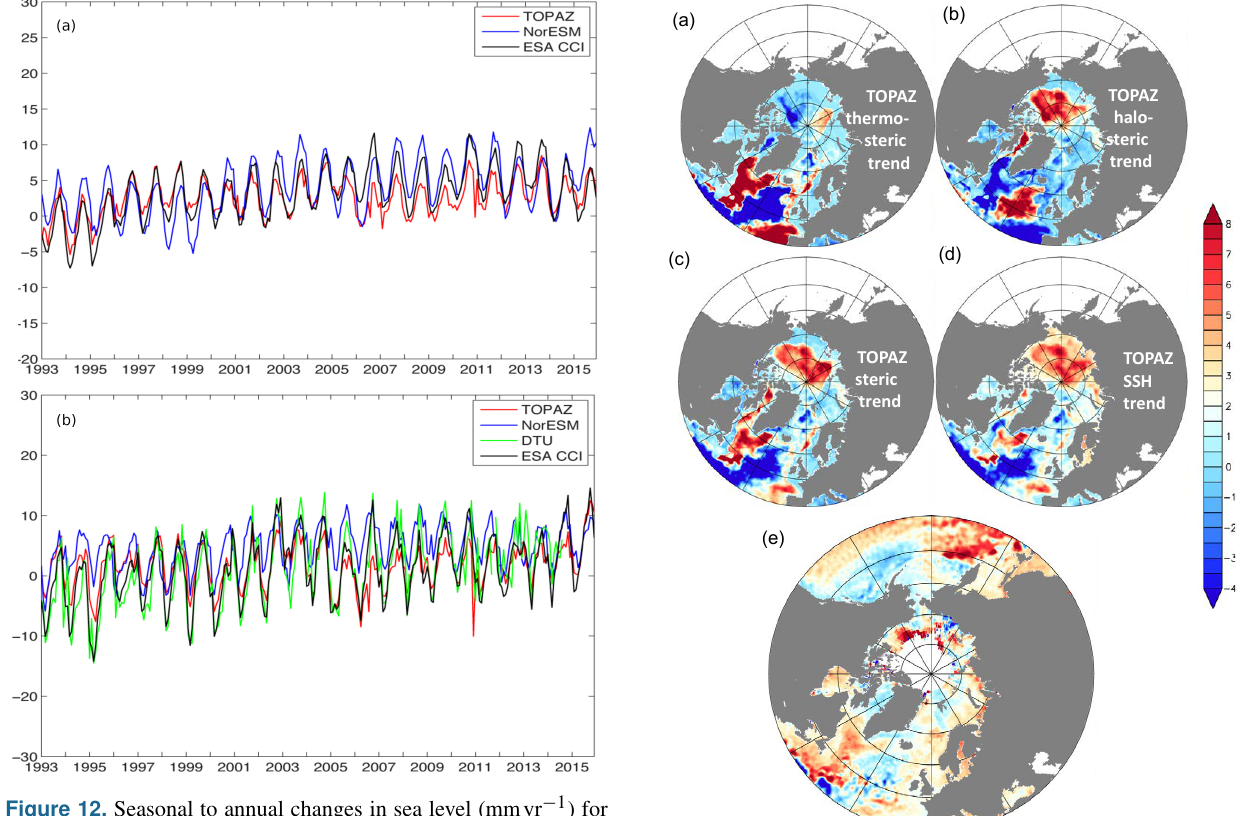
Figure 12. Seasonal to annual changes in sea level (mmyr − 1 ) for the period 1993–2016 for the Sub-Polar Gyre (a) and the Lofoten Basin (b) . For the Lofoten Basin the DTU-based sea level change is also displayed for the comparison. For both plots the vertical axis is in centimetres.